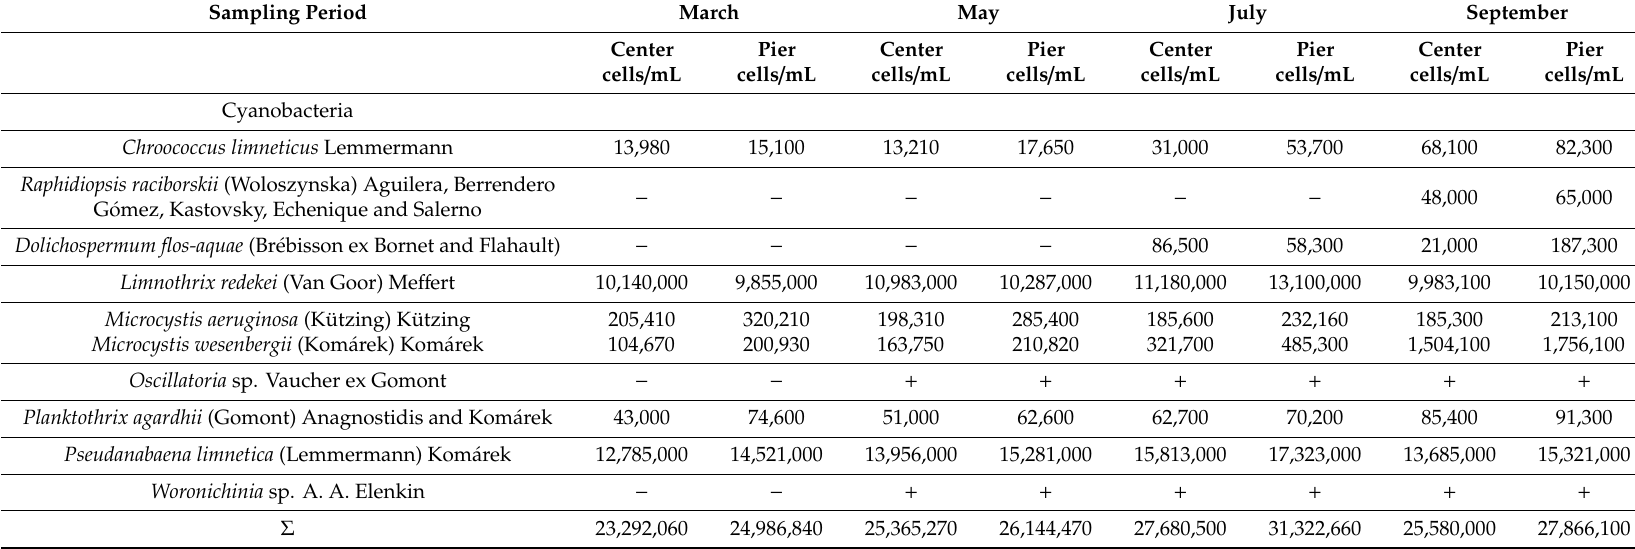
Table 3. Qualitative and quantitative composition of cyanobacteria from Lake Ludoš in 2018. Sampling